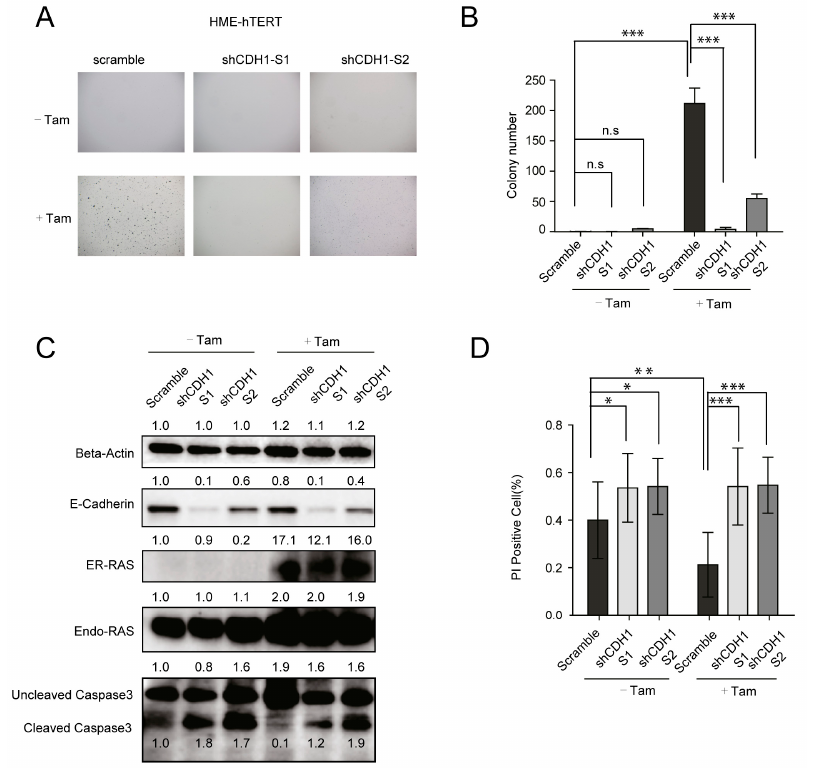
Figure 3. The upregulation of E-cadherin (CDH1) in HME-hTERT is necessary for cell survival and oncogenic RAS-stimulated proliferation under the soft-agar growth conditions. ( A ) Representative microscopic images of soft-agar colonies of HME-hTERT cells expressing ER-tagged CA-NRAS inducible by tamoxifen and expressing either a control shRNA (scramble) or two different shRNAs targeting CDH1. ( B ) Quantitation of the data from the experiment in panel A. The data represent the mean and SD of colony counts from five representative microscopic fields from the indicated condition. The study was repeated 3 times with similar results. *** p ≤ 0.001 (Student’s t -test). ( C ) Immunoblot analysis of protein samples extracted from HME-hTERT cells cultured in soft agar; the cells were treated the same way as in panels A and B in which expression ER-tagged mutant-NRAS was induced by tamoxifen (Tam) in the presence and absence of CDH1 knockdown. ( D ) Apoptosis analysis of HME-hTERT cells cultured in soft agar. The cells were seeded under the same experimental conditions as in panel A; apoptotic cells were quantitated by propidium iodide (PI) staining as detailed in Materials and Methods. Data shown represent the mean percentage of the PI-positive HME-hTERT cells in soft-agar. Quantification was done using five representative microscopic fields from a single experiment that has been repeated with similar results. The data are presented as mean ± SD . * p ≤ 0.05, ** p ≤ 0.01, *** p ≤ 0.001 (Student’s t -test).